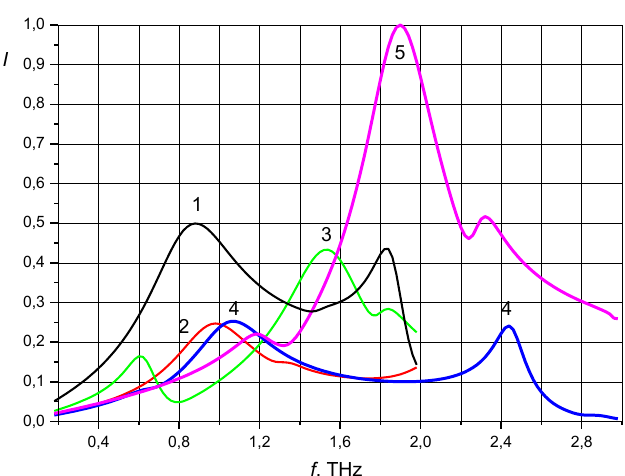
Fig. 4. Frequency dependences of the current density in the arrays of single or two connected graphene strips in the unit cell on the dielectric substrate: с urves 1- single graphene strip; 2- two connected identical rectangular graphene strips W = 25 μ m, l = 50 μ m. Curves 2- s -polarization, d =10 μ m; 3 - p - polarization, d=10 μ m; 4 - s- polarization, d =1 μ m; 5 - p -polarization, d =10 μ m; μ c = 0.25 eV. Other parameters are as in Fig. 2.